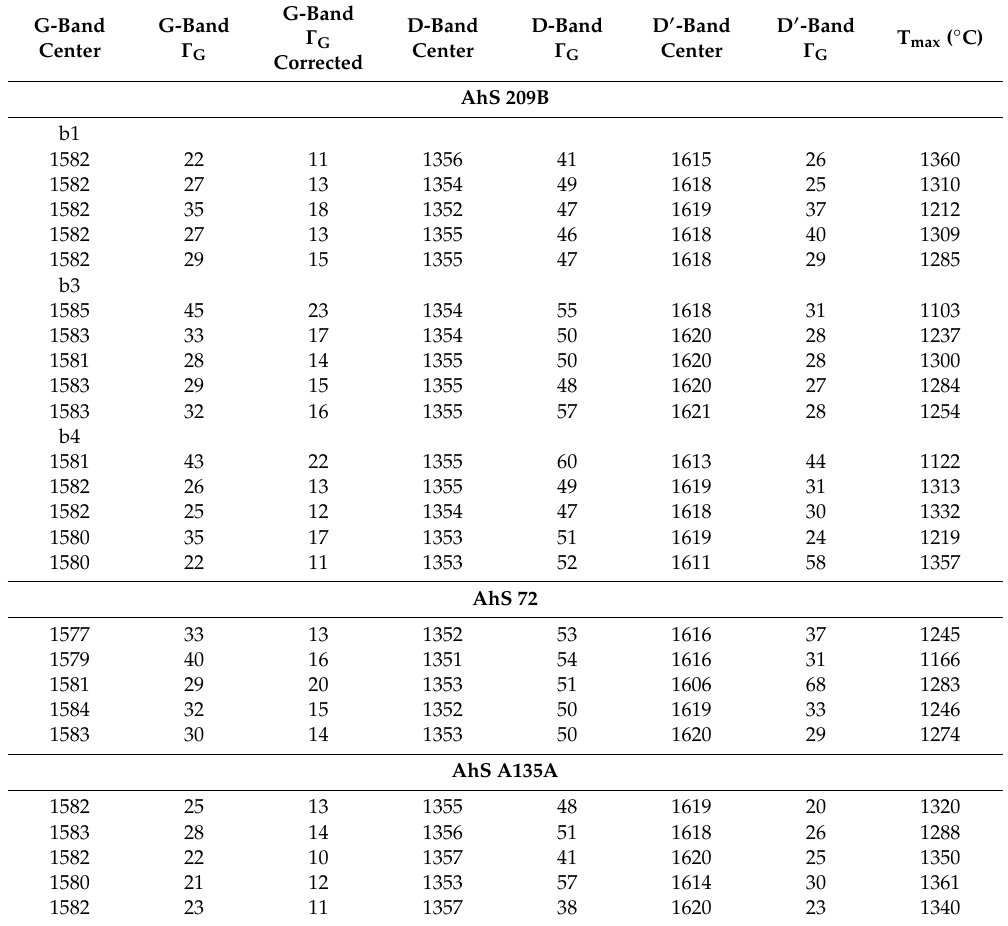
Table 2. Center positions for G-, D- and D (cid:48) -bands and Γ G (both in cm − 1 ) of all the studied samples. Calculated crystallization temperature, T max , is reported in the last column and was obtained using Equation (2). The uncertainty (2 σ ) of T max is ± 120 ◦